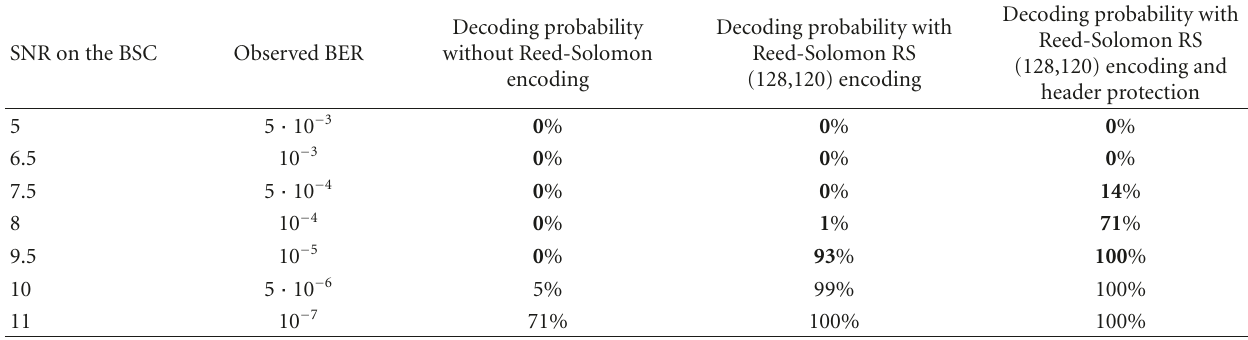
Table 2: Probability of decoding success for “Foreman” SVC encoded sequence (three layers) over a BSC channel.